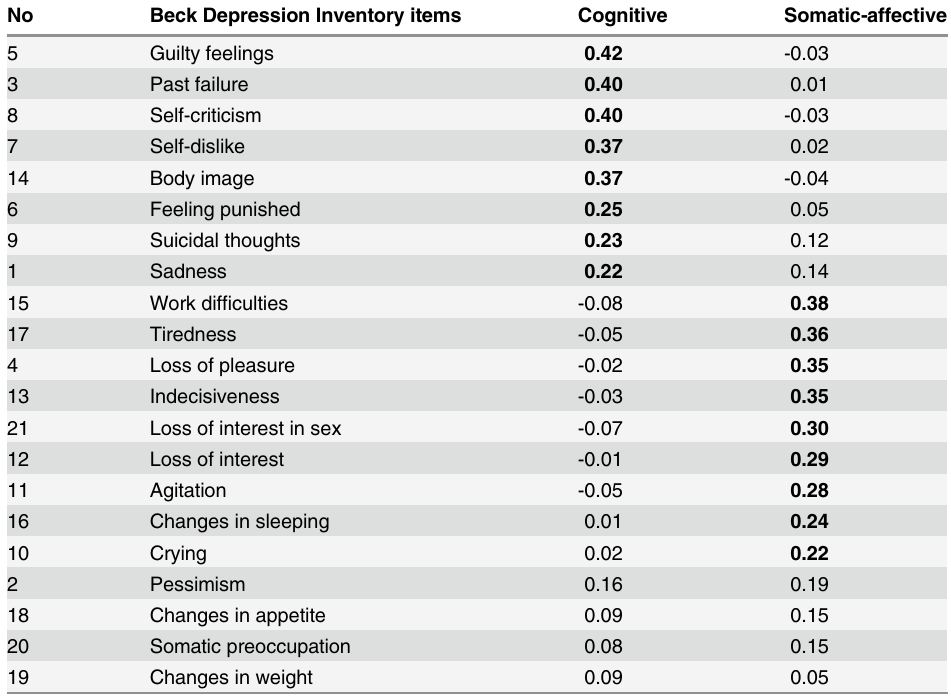
Table 2. The symptom-mode component scores averaged across 20 imputed data sets. Standard deviations (s.d.; computed across 20 imputed datasets) were at most 0.01 for all loadings. Component scores (cid:1) 0.20 are printed in bold